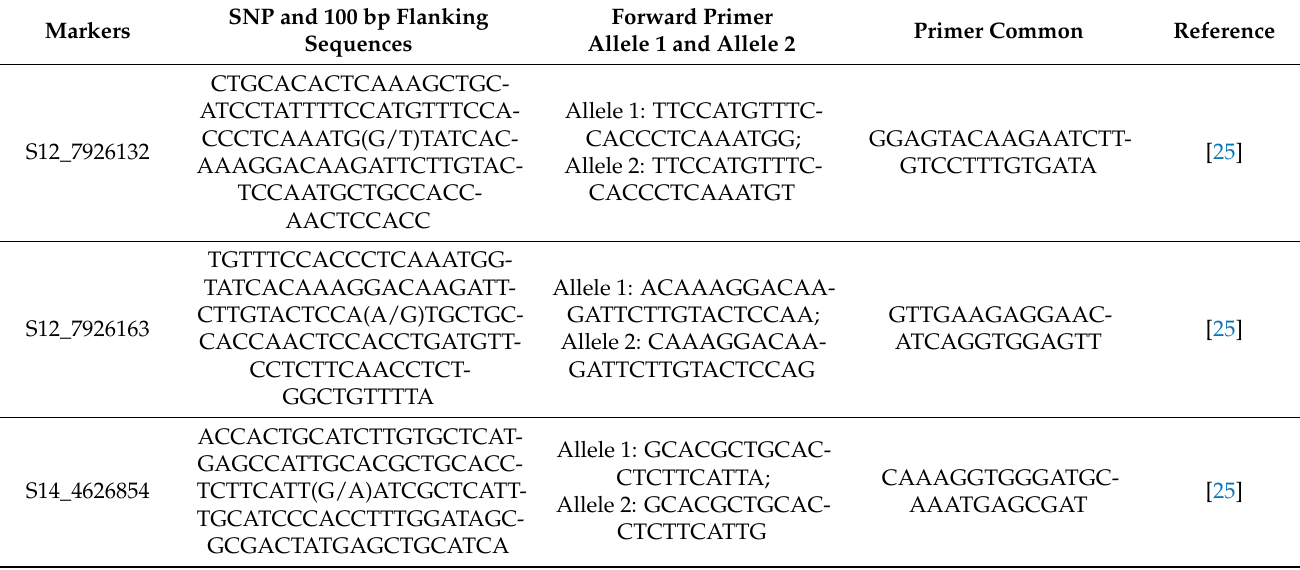
Table 2. Flanking sequences of SNP markers linked to cassava mosaic disease (CMD) resistance and their Kompetitive allele-specific PCR (KASP)